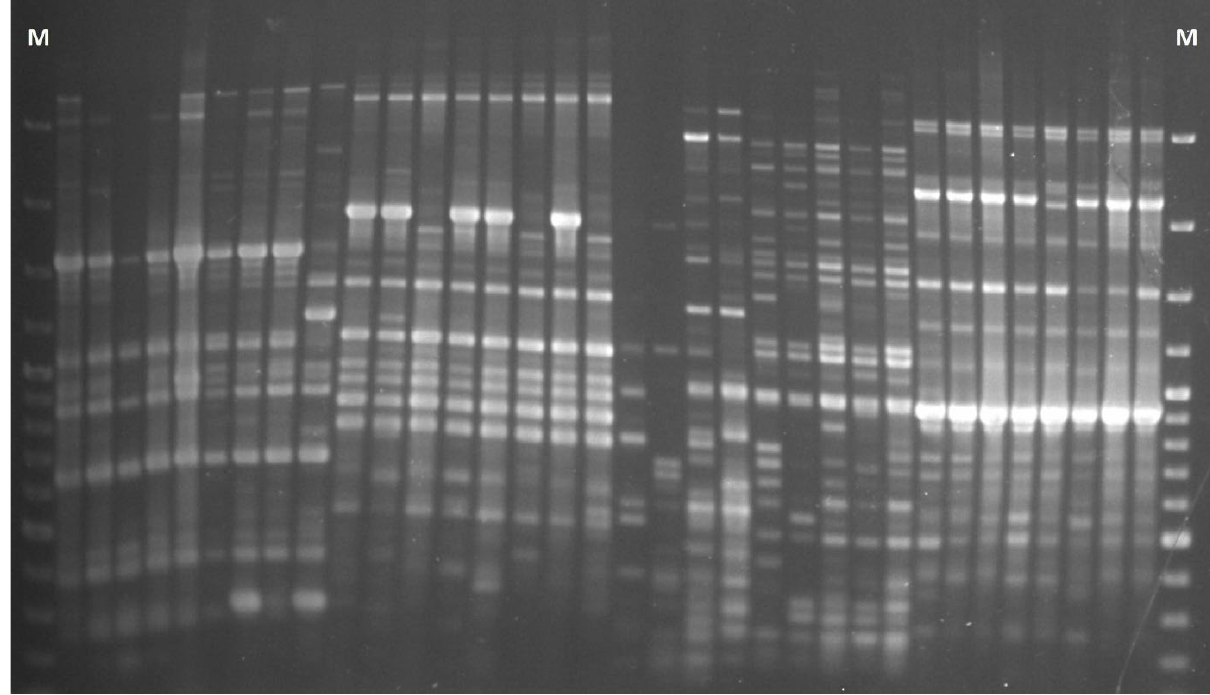
Figure 1. A representative gel of reproducible profiles with iPBS2239 primer. Sample order (from left to right) is as listed in Table 1. The DNA marker (M) is GeneRuler 100 bp plus (Thermo